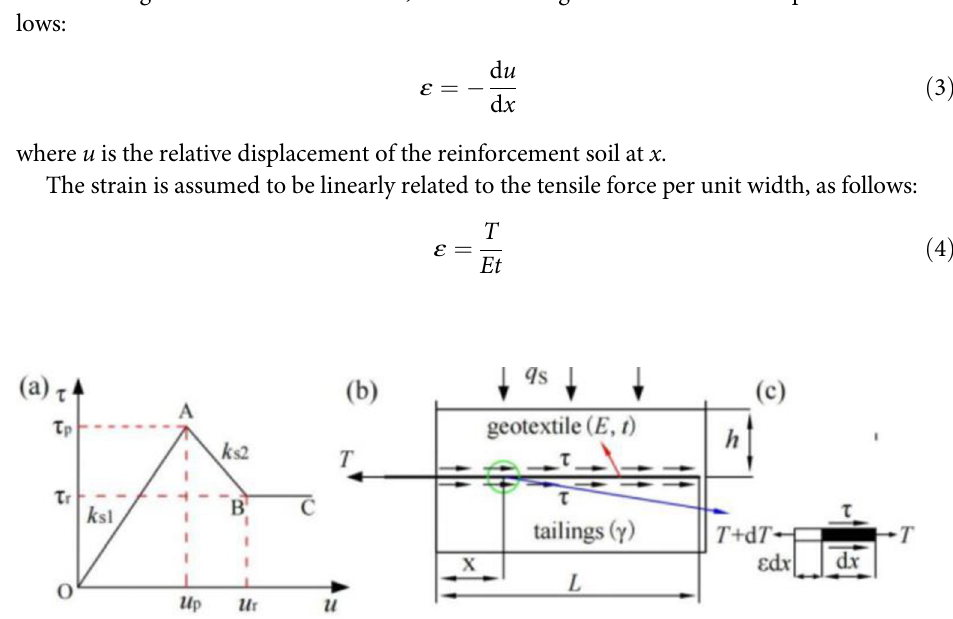
Fig 5. Schematic of the pull-out interface between geotextiles and tailings: (a)Trilinear relationship between the interface shear stress and displacement; (b) overall reinforcement stress; (c) force analysis of the reinforcement micro-